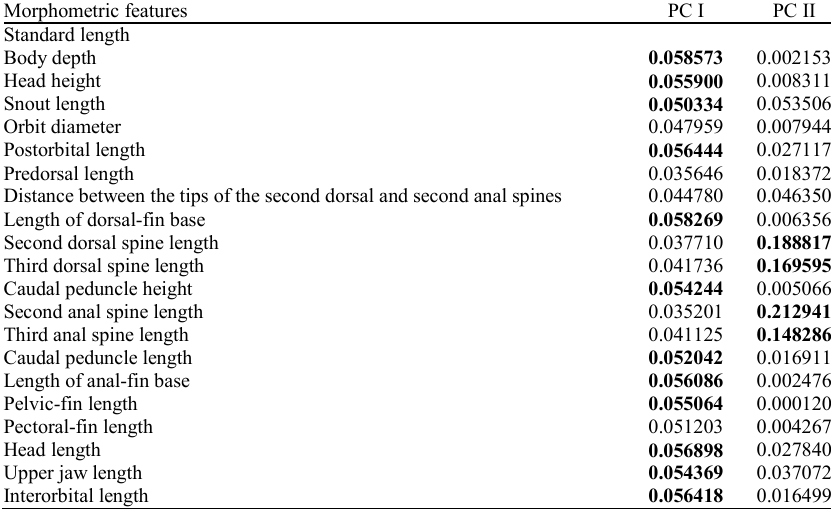
Table 3 . Character loading on principal components I-II for 16 measurements taken on 42 specimens of E. castroaguirrei and 125 of E. mexcanus from the Grijalva-Usumacinta River Basin. Bold values represent the variables that loaded most heavily on PC-I and